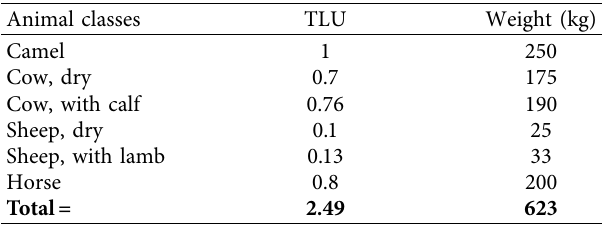
Table 1: Tropical livestock unit (TLU) and its signifying weights of livestock. Animal classes TLU Weight (kg) Camel 1 250 Cow, dry 0.7 175 Cow, with calf 0.76 190 Sheep, dry 0.1 25 Sheep, with lamb 0.13 33 Horse 0.8 200 Total= 2.49 623 Source: adapted from diferent studies [56, 57]. 2.49 is the mean TLU (tropical livestock unit) and 623 is the total corresponding weight for the averageTLU(2.49).Inotherwords,2.49 TLU � 623kg oflivestockclassesin tropical region. For instance, 1 TLU � 250 kg, which is for camel in tropical region. Its weight may vary in diferent regions (for e.g.,